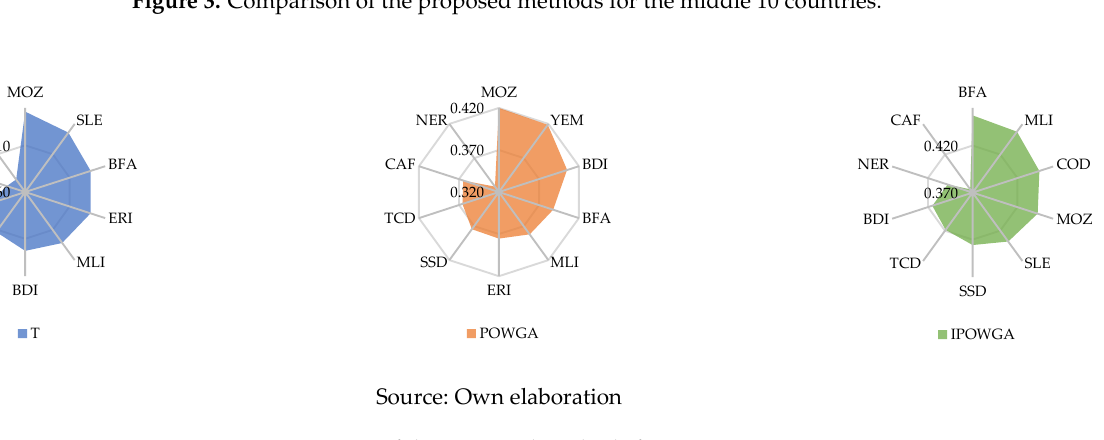
Figure 3. Comparison of the proposed methods for the middle 10 countries.